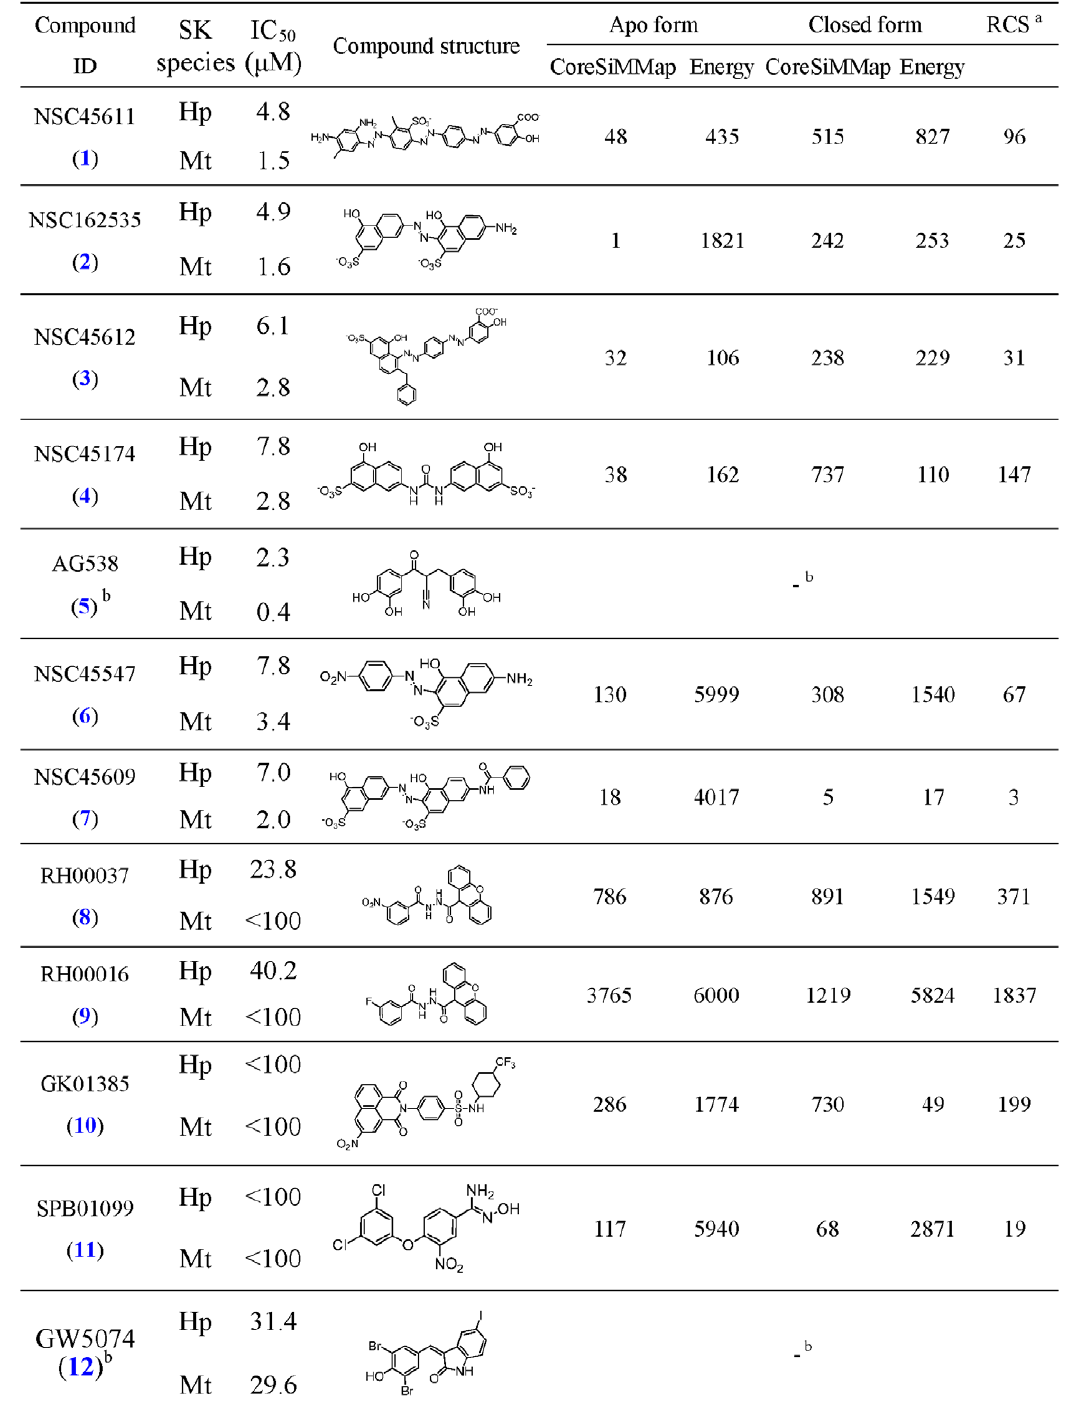
Figure 4. Ranks of active compounds using CoreSiMMap, energy-based, and combined scoring methods for apo and closed forms of HpSK and MtSK.